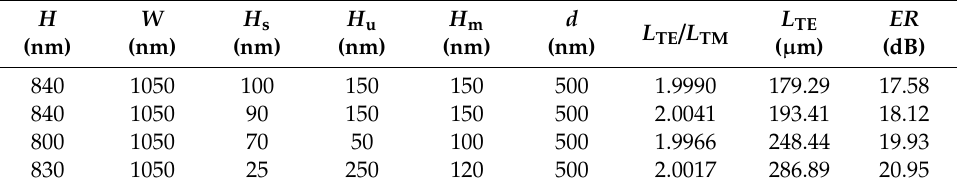
Table 2. Optimized Parameters of the Multi-Slot Waveguide-Based